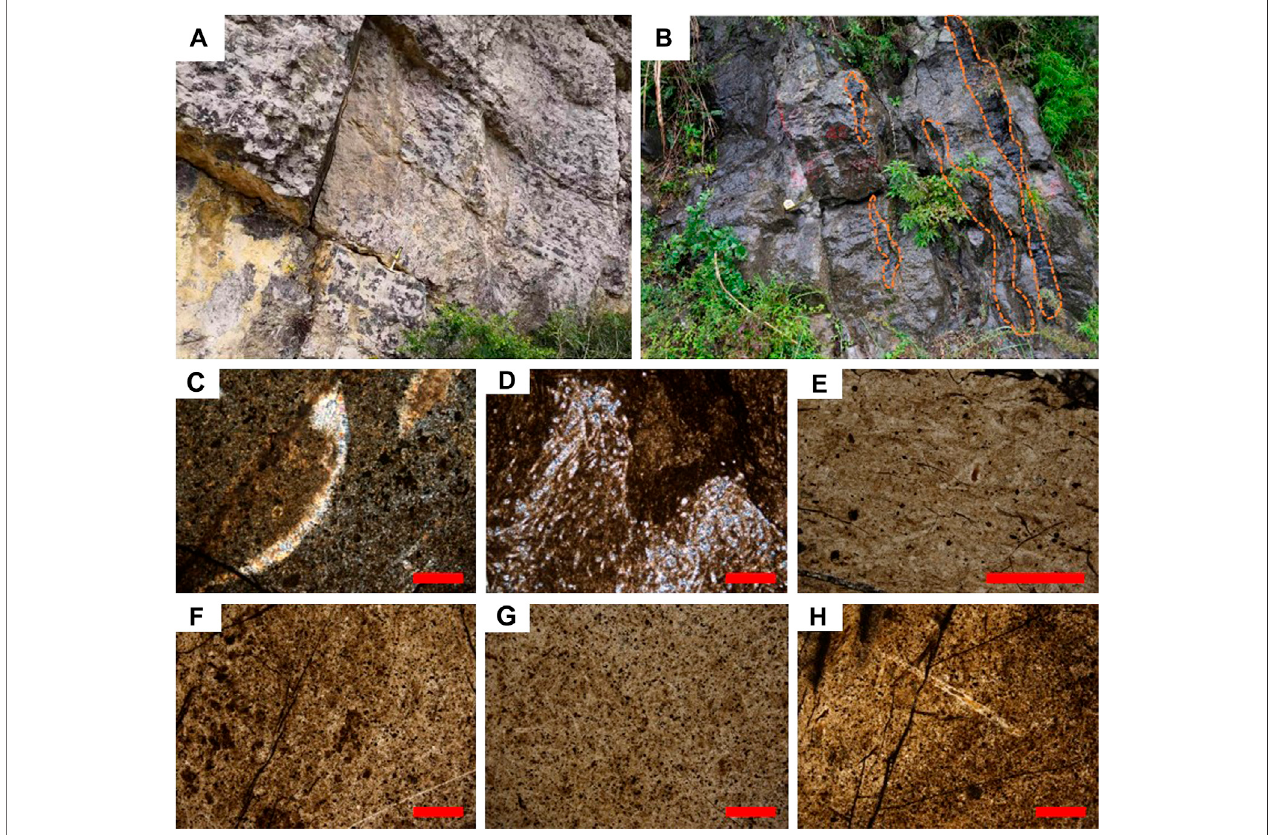
FIGURE 2 | Field photographs and photomicrographs of the Permian chert nodules. (A) Field photograph of the Lianziya section; (B) Field photograph of the Maoertang section; (C – H) Photomicrographs of chert nodules. Scale bars are 500 μ m in Figures 2C – H .